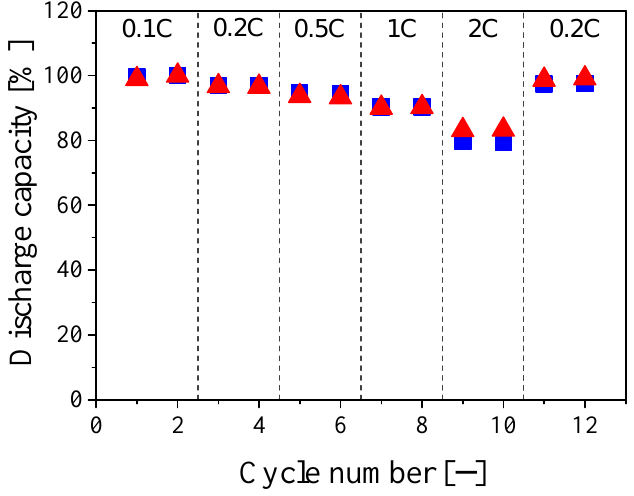
Figure 6. Discharge capacity, normalized with respect to the initial cycle at 0.1C, at 60 ◦ C of the PSiCIL membranes containing 70 wt.% of IL with 0% (blue squares) and 10% (red triangles) of SiO 2 ,